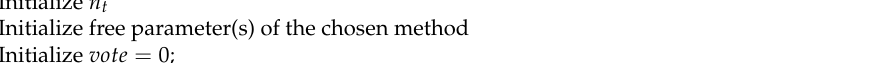
Table 5. The Voting-based LOPO-CV